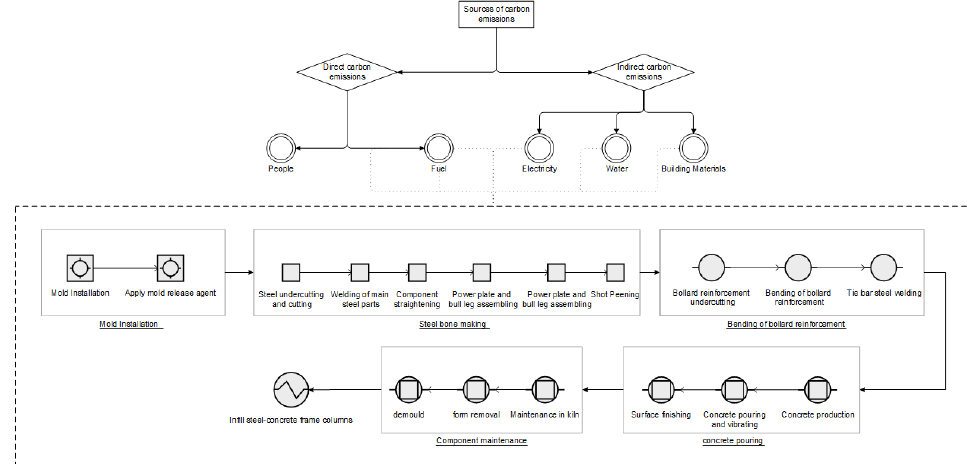
Figure 4. Sources of carbon emissions from concrete frame